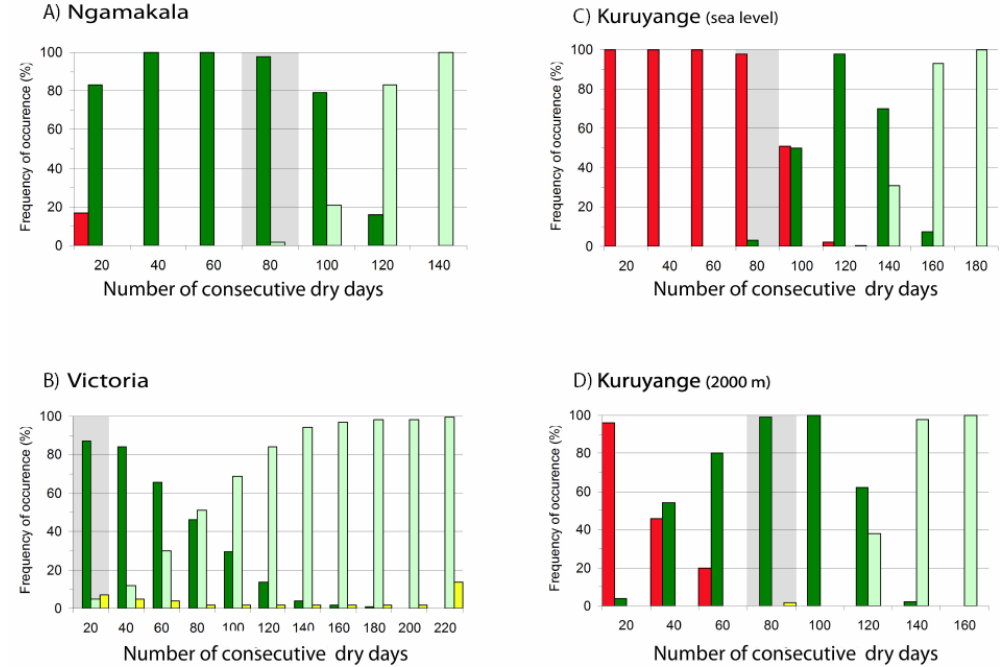
Fig. 6. Frequency of occurence by class of number of consecutives dry days of the Biome types simulated for each site. In red, Tropical Evergreen Forest biome; in dark green, Tropical Semi-Deciduous Forest biome; in light green, Tropical Deciduous Forest/Woodland biome; in yellow, Tropical Savanna for (A) Ngamakala (Congo), (B) Victoria (Uganda), (C) Kuruyange (Burundi) with atmospheric pressure mea- sured at the sea level and Kuruyange (Burundi), (D) with atmospheric pressure at 2000m, calculated applying an empirical correction to take into account the altitudinal effect. In grey, current number of consecutive dry days according to the climatic database (Leemans and Cramer,